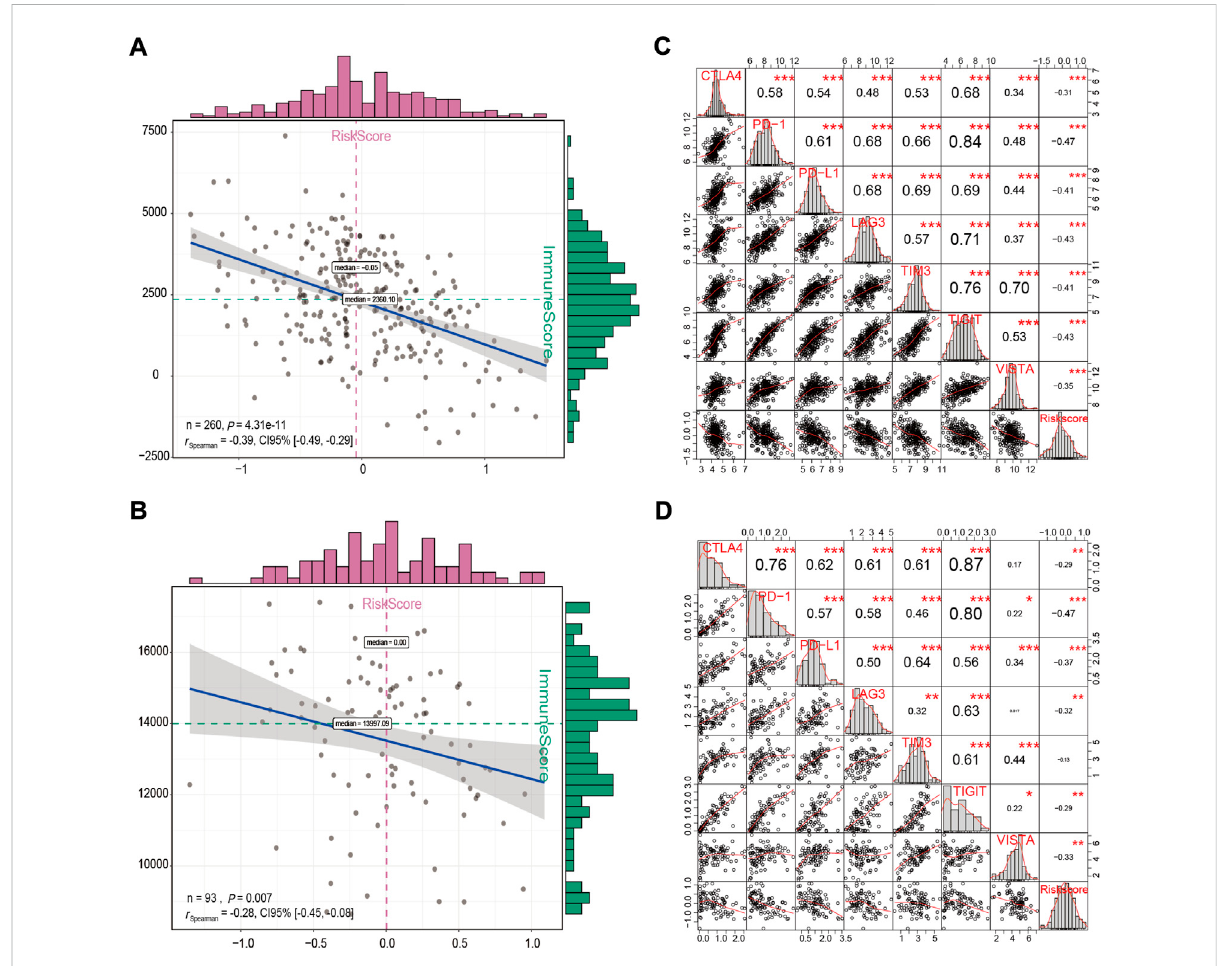
FIGURE 11 Correlation analysis between the immune score and the risk score (A,B) , and between the risk score and the expression levels of immune checkpointmolecules (C,D) in theGSE32062 (A,C) and ICGC (B,D) cohorts. * p < 0.05; ** p < 0.01; *** p < 0.001. ICGC, International Cancer Genome